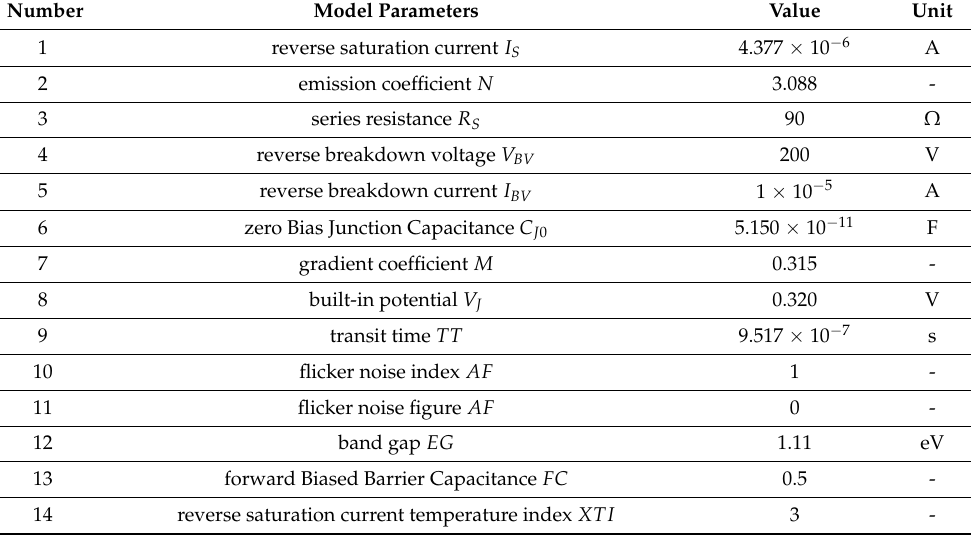
Figure 16. The EMC model of the diode 2CZ106C. Figure 17. PCB board for model verification ( a ) design drawing; ( b ) Processed circuit board.